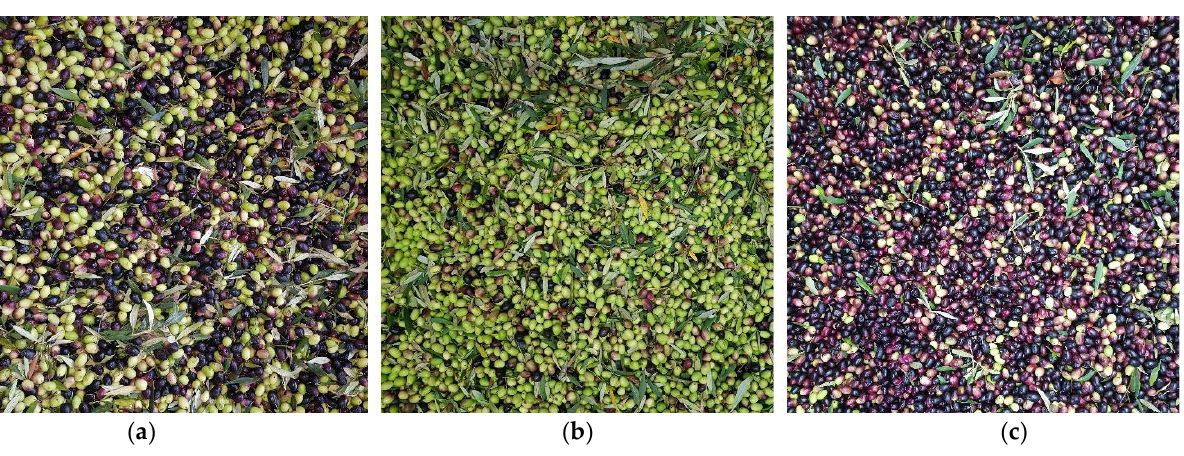
5 of 12 Table 1. Sorting machine characteristics. Characteristics